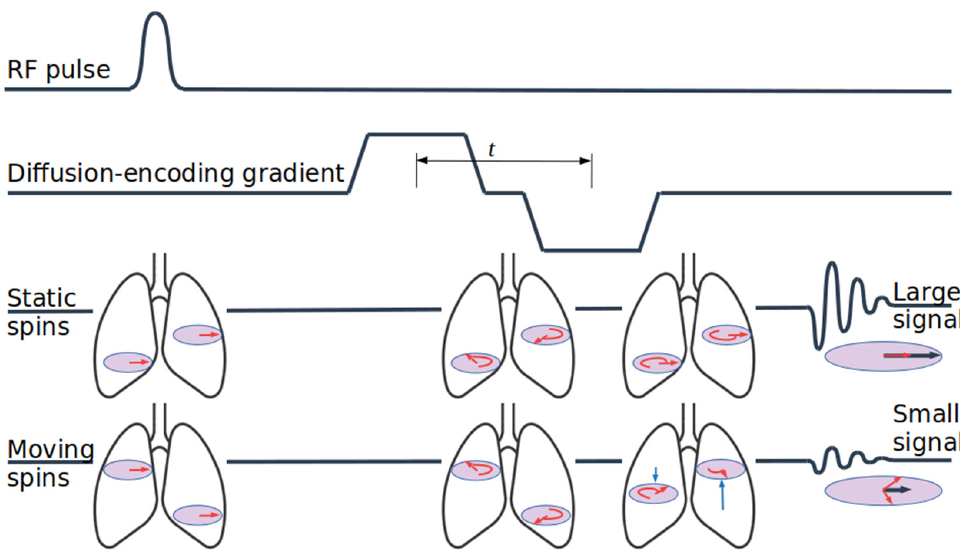
Figure 8. A simplified depiction of diffusion-encoding to measure the Apparent Diffusion Coefficient. An RF pulse (top) is applied to generate a net transverse component of the hyperpolarized spins (bottom two rows, left, red arrows). These spins are then subject to a spatial field gradient, causing the spins to dephase based on position (second row). An inverse gradient is then applied to reverse the spatially-dependent dephasing, resulting in restoration of the full MRI signal (third row). If, however, individual atoms move significantly during or between the gradient pulses (bottom row, blue arrows), the rephasing is not complete, resulting in ca diminished MRI signal from which effective diffusion parameters can be extracted.